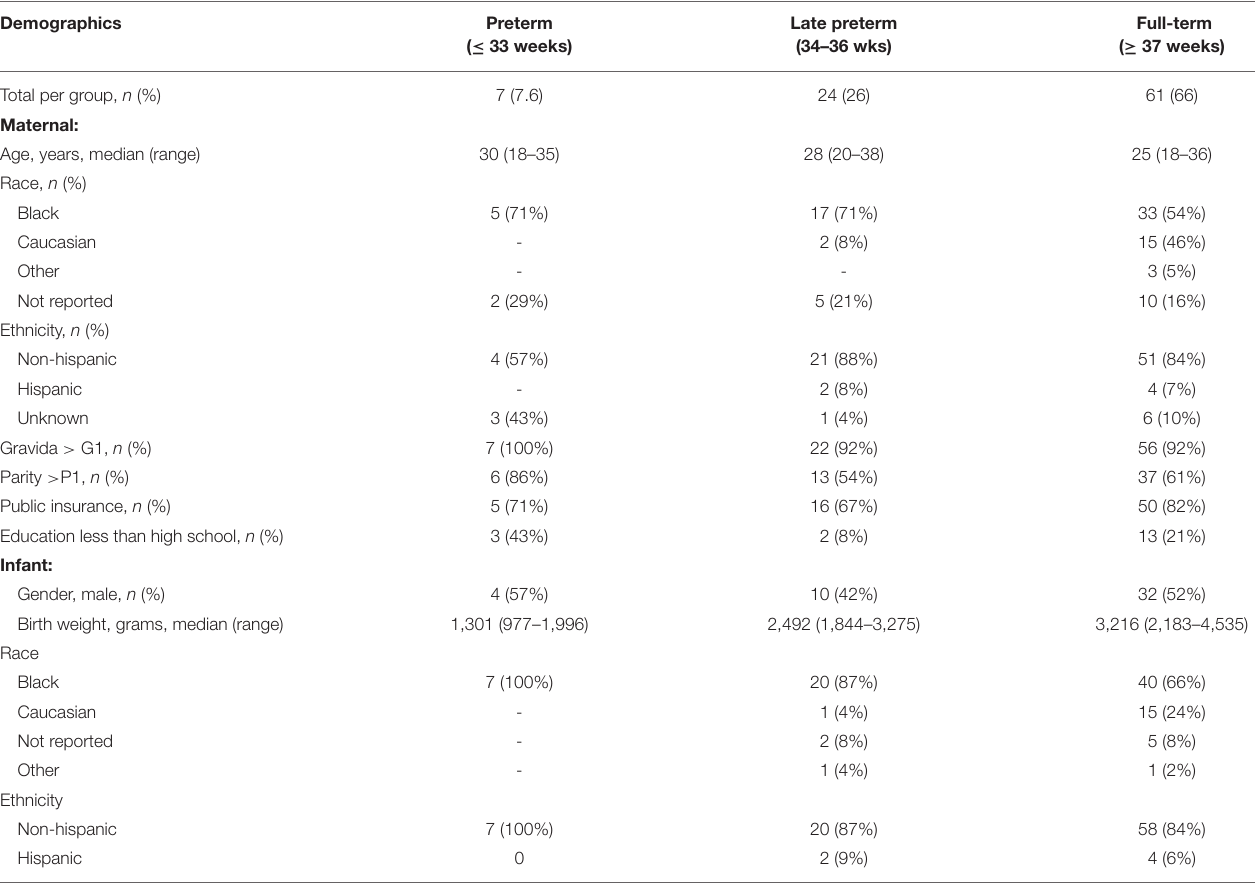
TABLE 1 | Maternal and infant